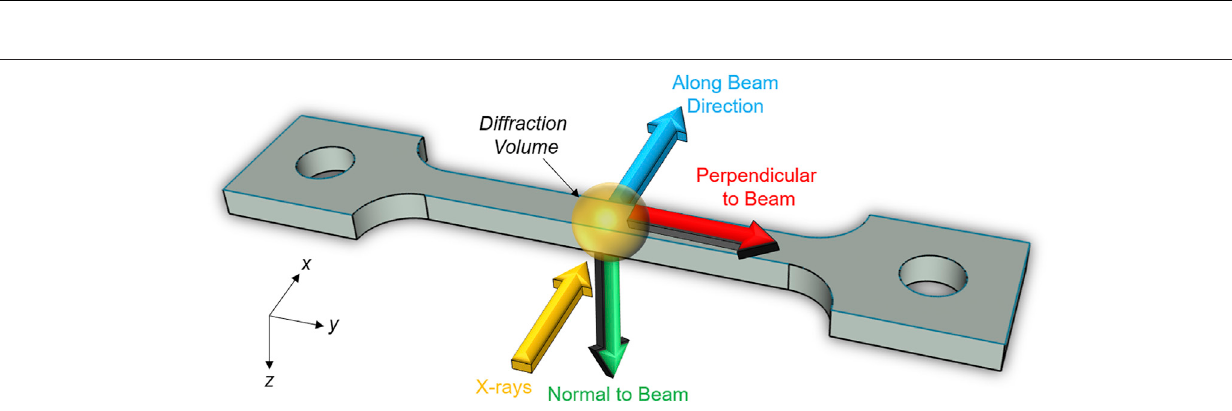
Frontiers in Materials |